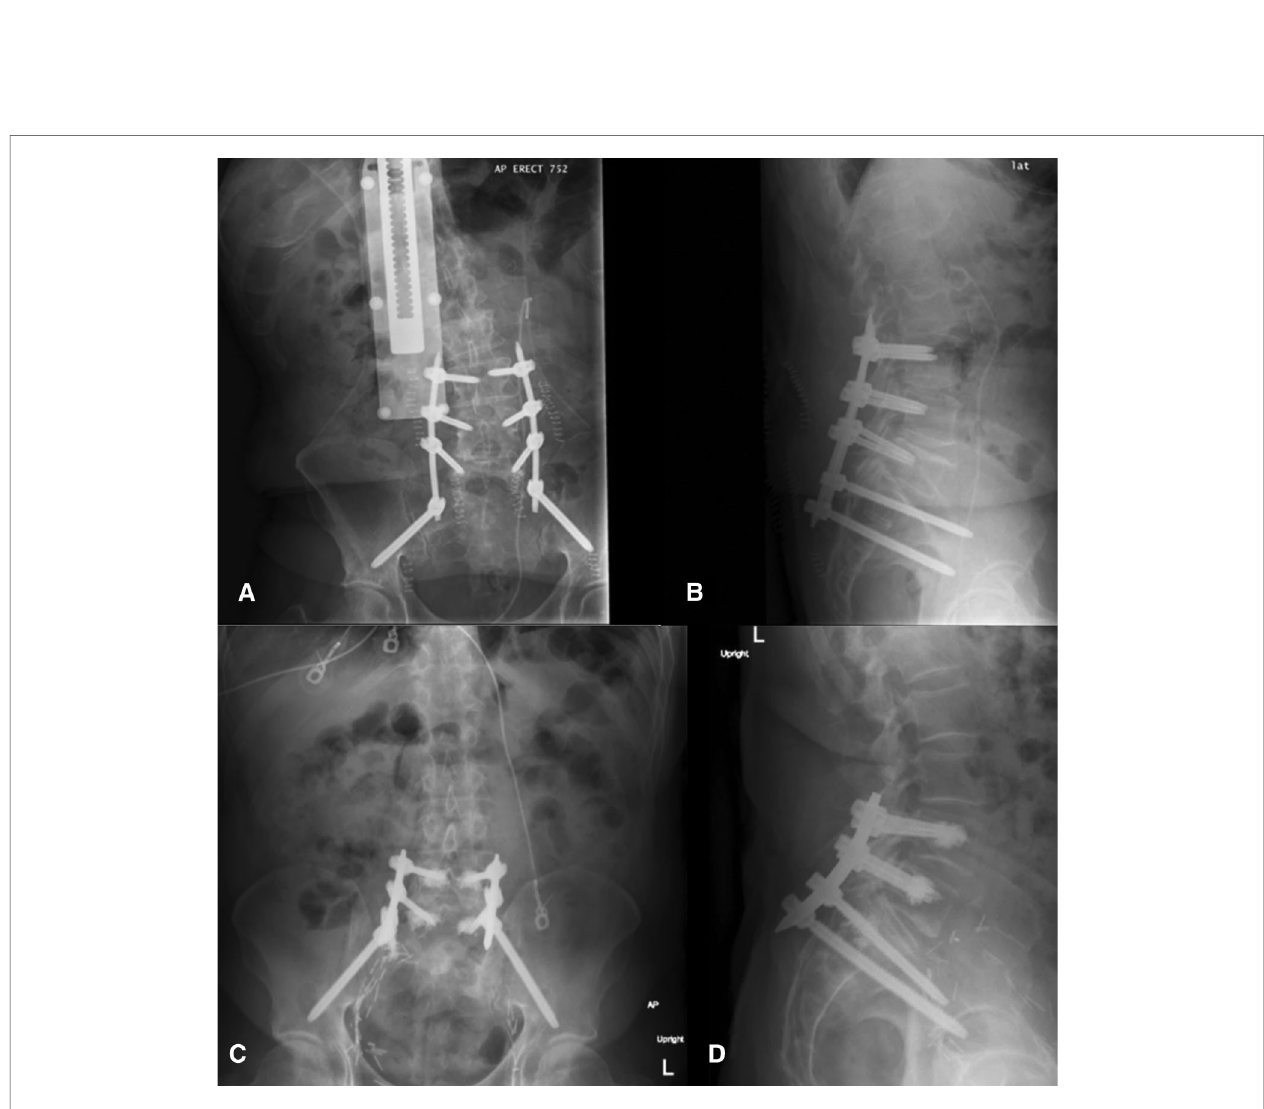
FIGURE 4 | Postoperative upright x-rays for Cases 1 (( A ) AP; ( B ) lateral) and 2 (( C ) AP; ( D ) lateral) of the fi xation construct demonstrating good screw placement (from (22), used with permission).